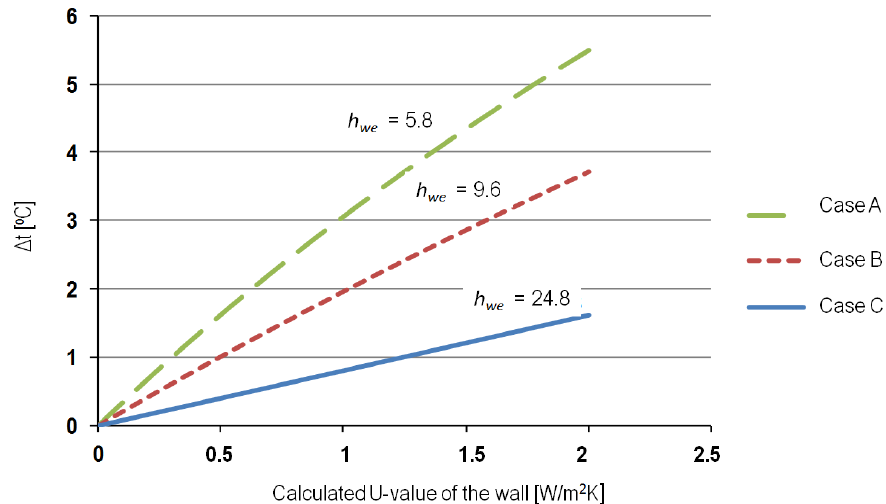
Figure 1. Outside wall-surface temperature difference as a function of U-value of the